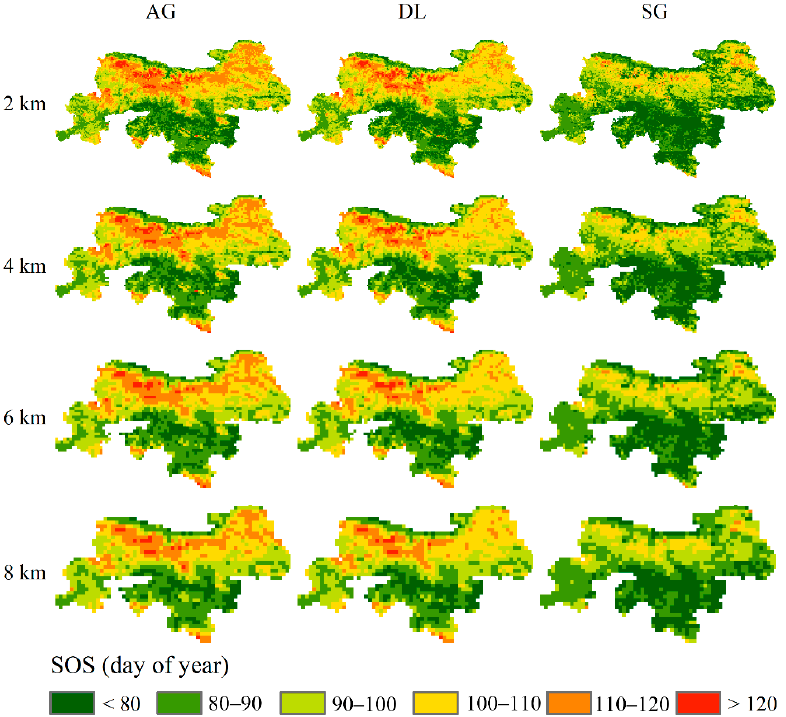
Figure A1. Up-scaled SOSs from 250 m SOSs. (SG, Savitzky-Golay; AG, asymmetric Gaussian; DL, double logistic.)